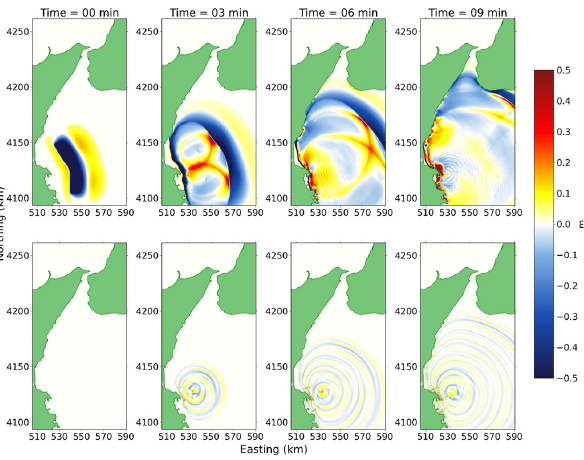
Fig. 8. Tsunami propagation snapshots for 1693 E (upper panels) and 1693 L (bottom panels) scenarios.